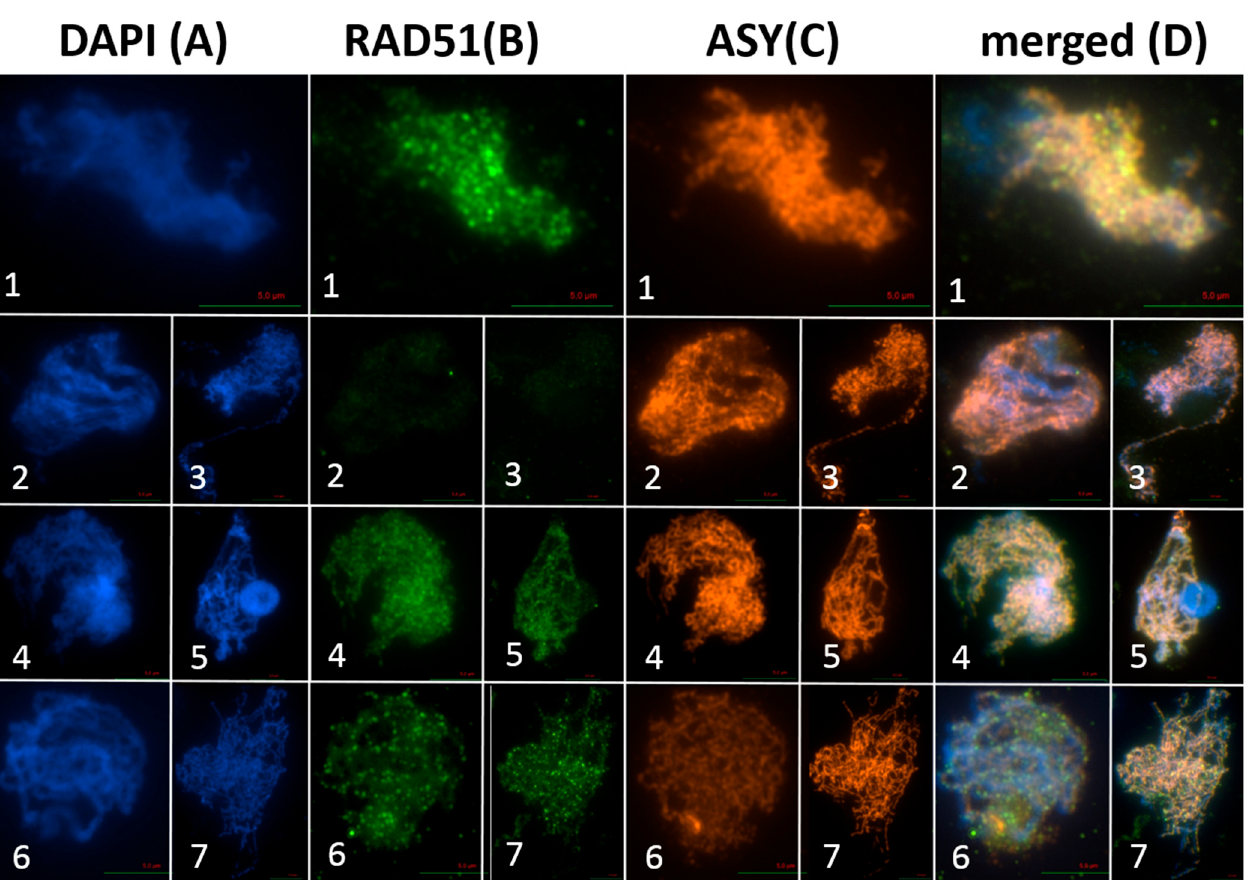
Figure 7. Dual immunolocalization of ASY1 and RAD51 proteins: Meiocytes were counterstained with DAPI (A) and dual immunolocalization of RAD51 (B) and ASY1 (C) was performed, single channel pictures were merged afterwards (D). Rabbit polyclonal IGg antibody against ASY1 and rat polyclonal IGg antibody against RAD51 was used. Meiocytes of Col-0 (1), spo11-1-3 (2), spo11-2-3 (3), spo11-1-3 -AthSPO1g (4), spo11-2-3 -AthSPO2g (5), Col-0-AthSPO1g (6) and Col-0-AthSPO2g (7) were used for immunolocalization. Bar = 5 µm.